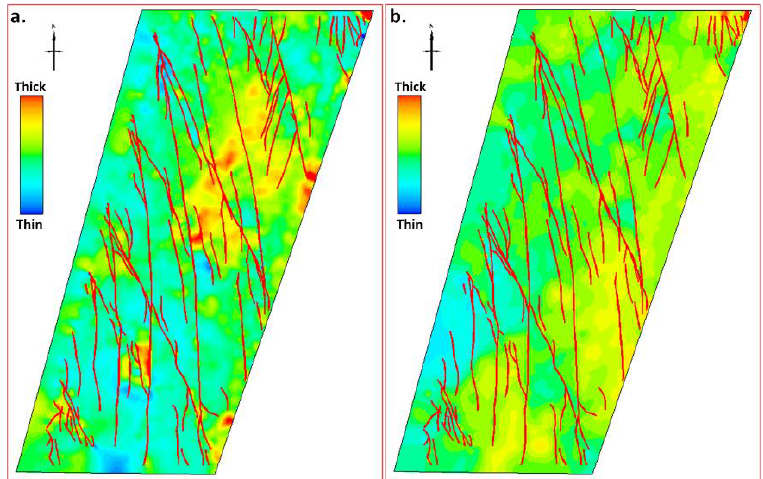
Figure 7. Thickness maps of Unit 4 ( a ) and Unit 5 ( b ). The depositional thicknesses of the two geologic unit have an inverse trend. Unit 4 has thick depositions in the north and thinner depositions in the south. However, in Unit 5, the thick depositions develop in the north and thinner develop in the south of the field.